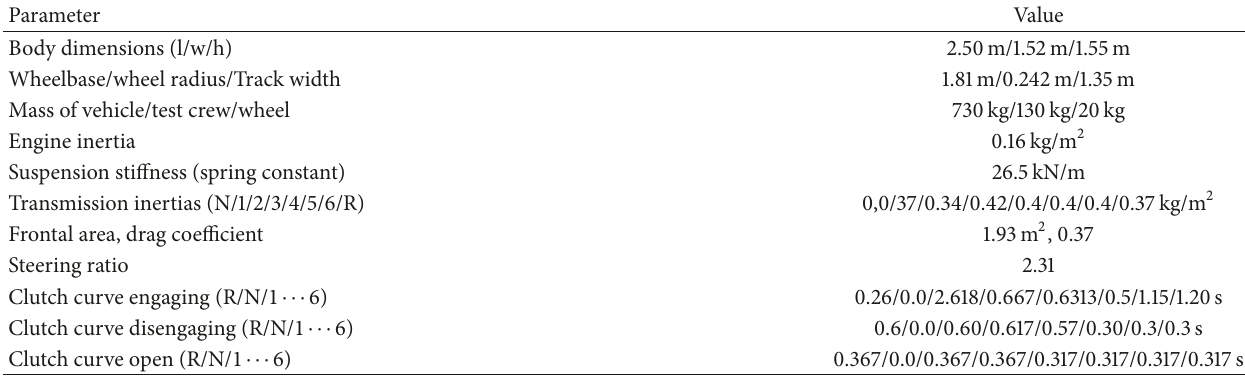
Table 4: Vehicle properties.